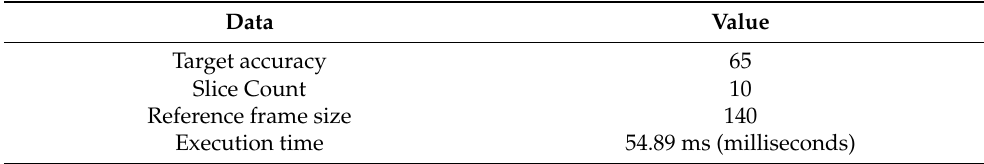
Table 3. The data used to derive the results of the two pictures.